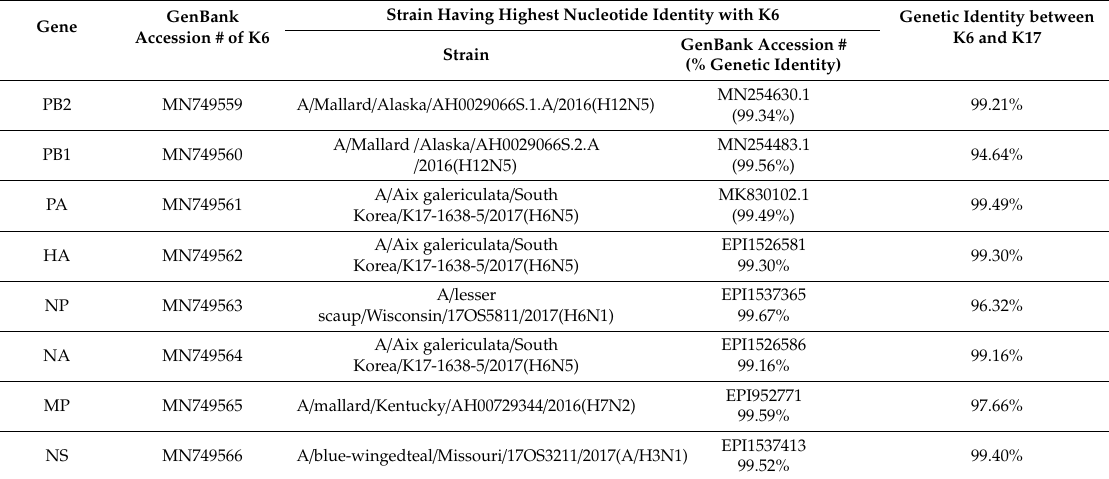
Table 1. Sequence homology of the whole A / Bean goose / South Korea / KNU18-6 / 2018(H6N5) genome.